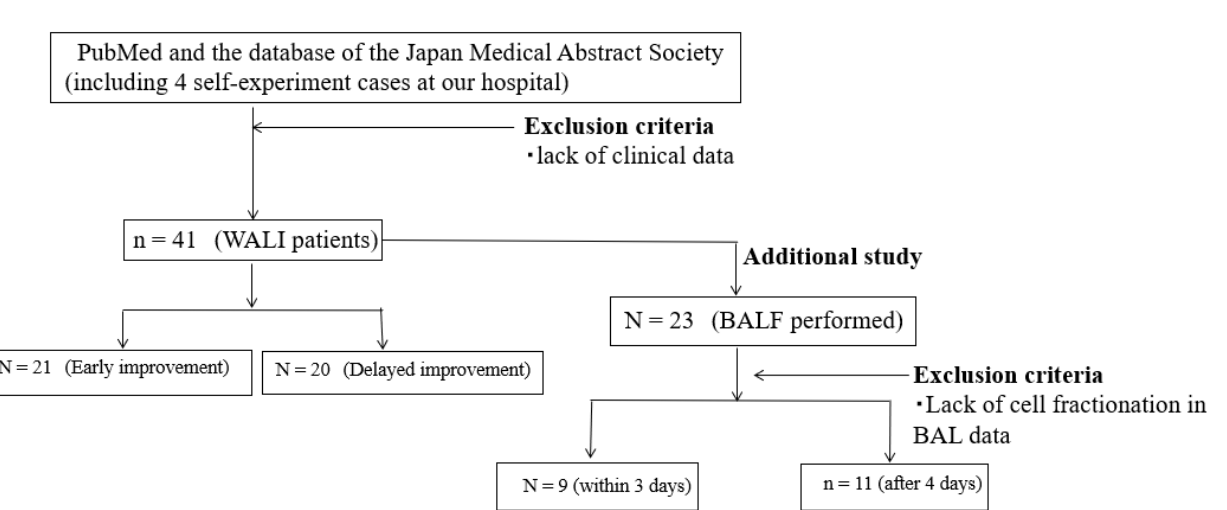
Table 1. Comparison of clinical characteristics of early and delayed improvement of WALI (n = 43).